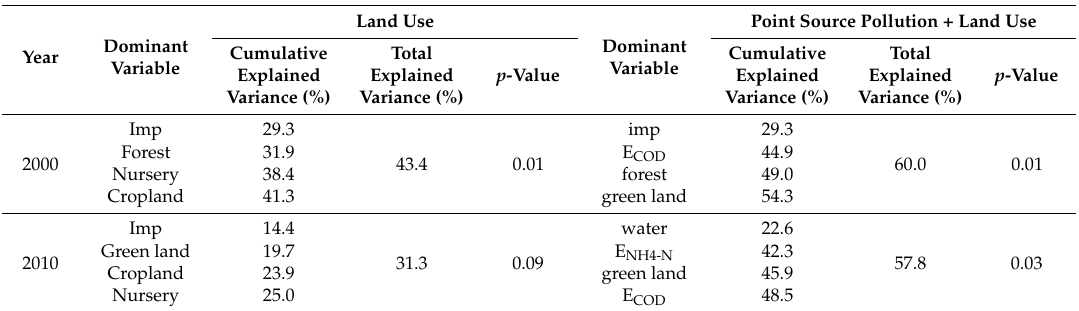
Table 2. The dominant land use groups with the maximum explanatory power within 2000 m buffer scale in 2000 and 2010.